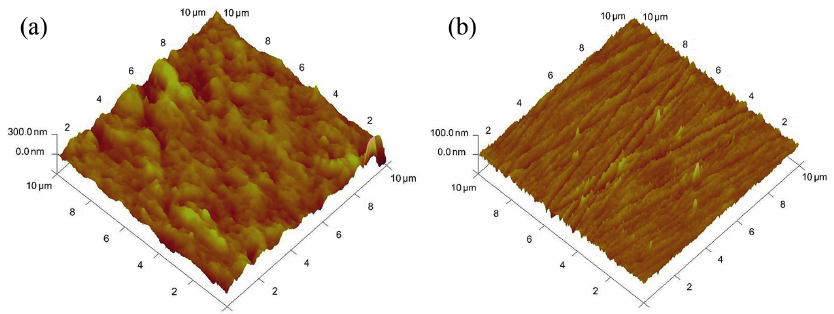
Figure 2: Surface topography before bonding obtained by AFM: (a) Al; (b) Mg.